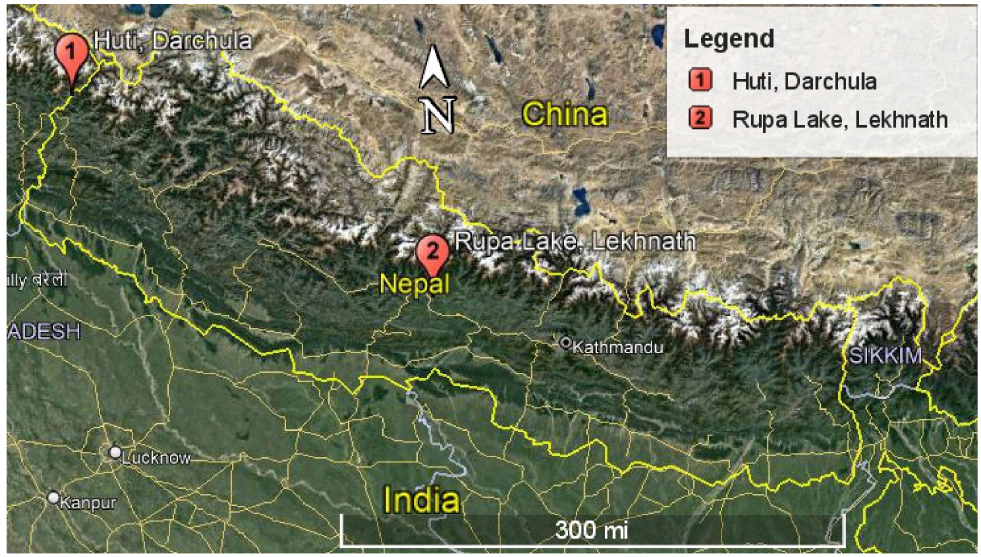
Figure 1. Map of Nepal showing the sites for the collected soil